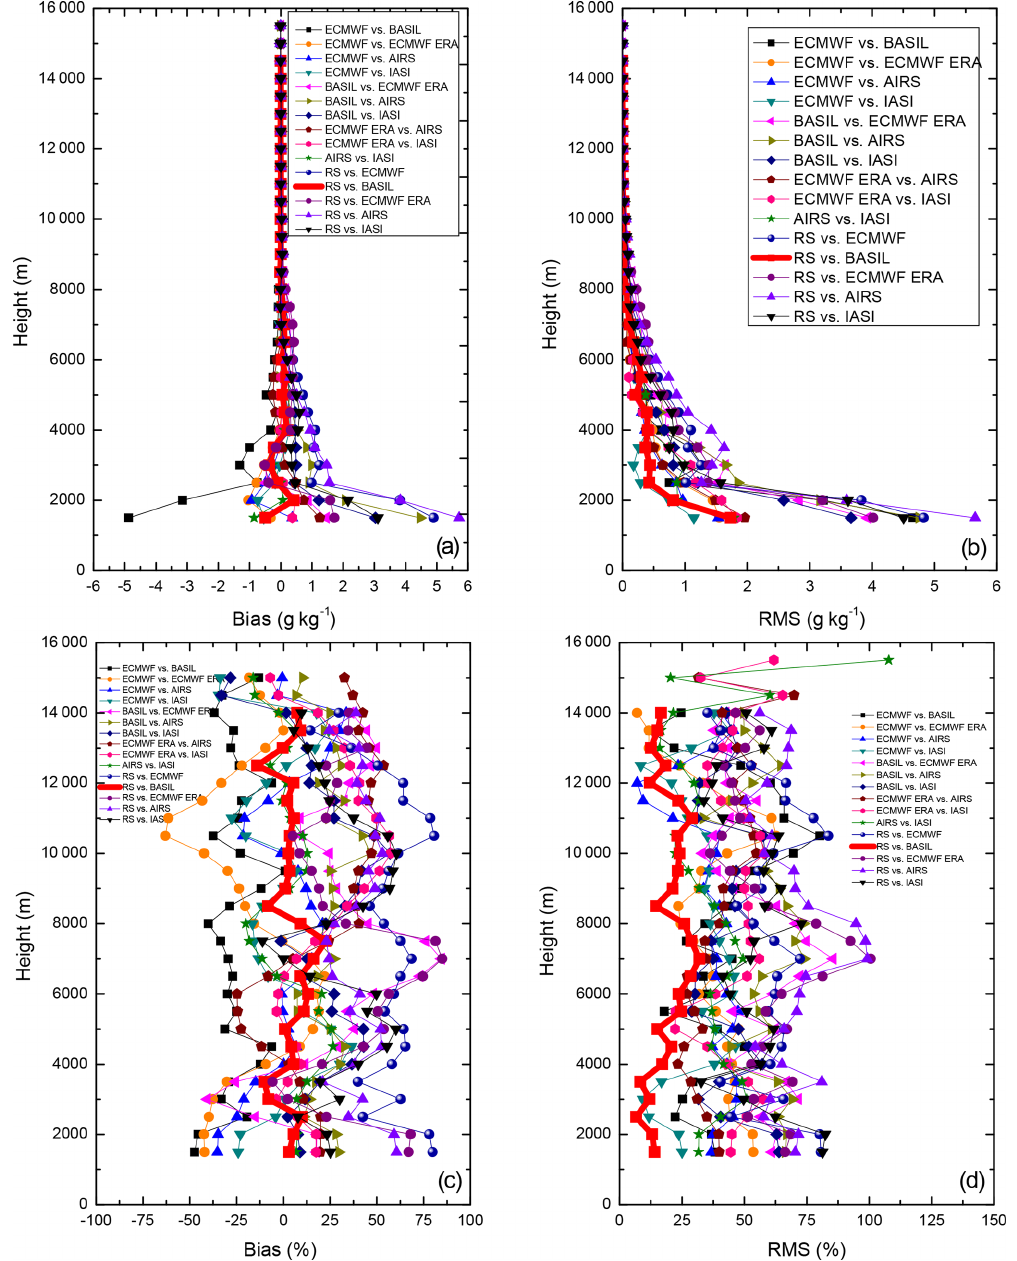
Figure 6. Vertical profiles of the water vapour mixing ratio mean bias and RMS deviation for all sensor/model pairs: bias (a) , RMS (b) , per- centage bias (c) and percentage RMS (d)